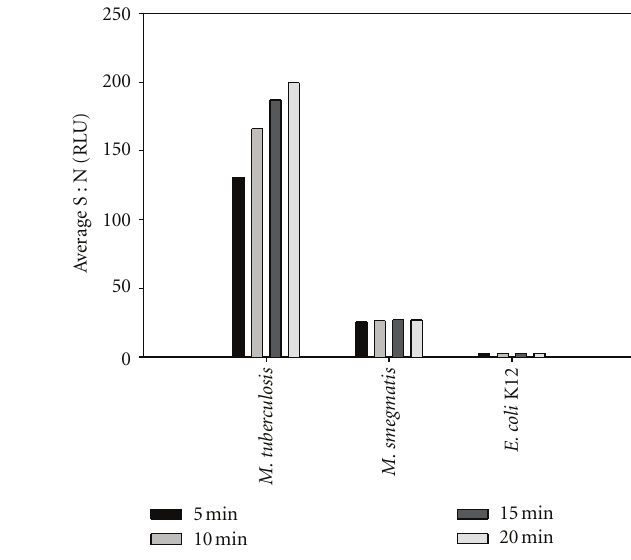
Figure 3: IMS/ATP assay at approximately 10 6 CFU/ml in PBS containing 0.1%